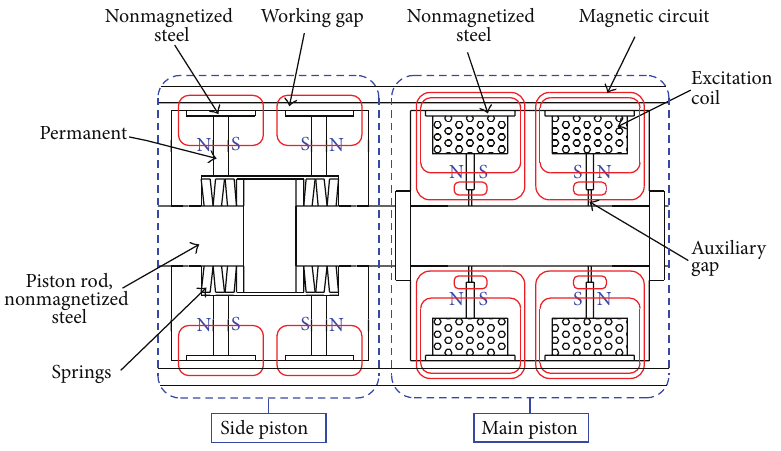
Figure 2: Flux lines of the SDMR damper.